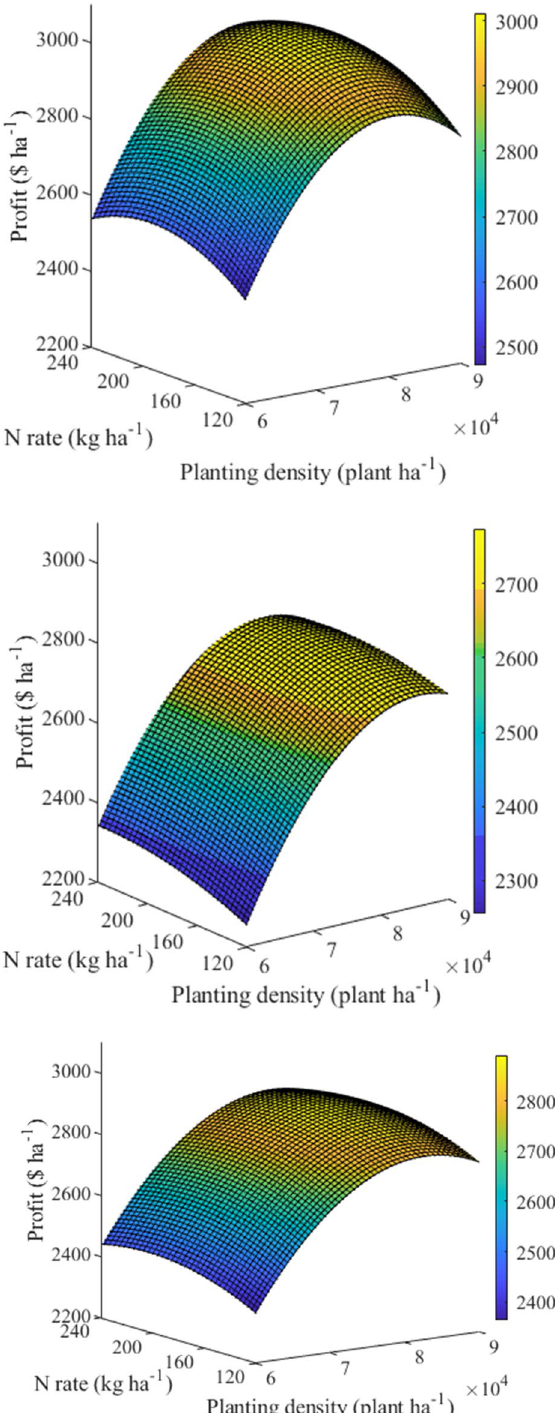
Figure 2. Quadratic polynomial trend surface fitting of profit, N application rate, and planting density. x was set as N application rate, y was set as planting density, and z was set as profit to show the effects of N application rate and planting density on the profits of 2017 (up) and 2018 (middle) and 2 years’ mean